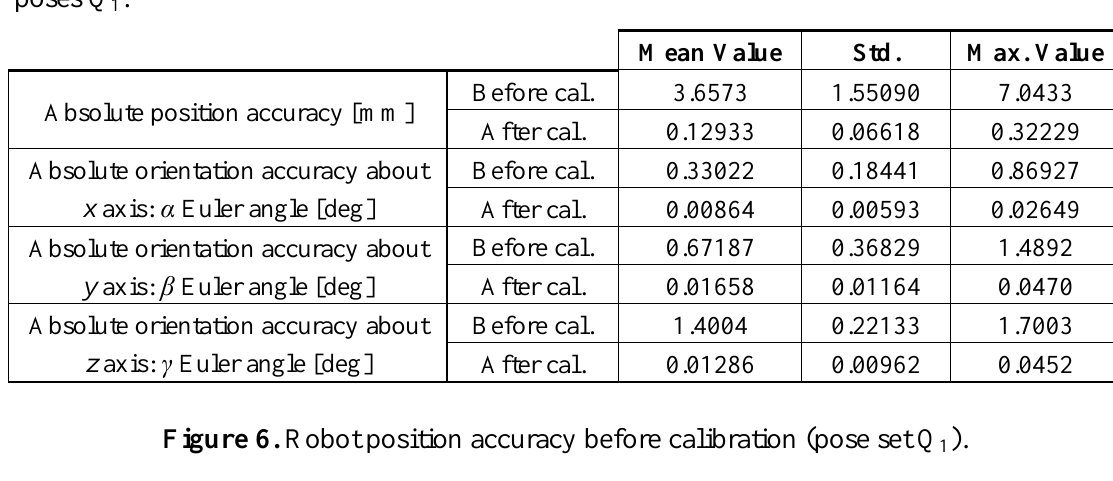
Table 4. Absolute position and orientation accuracy of the robot over the set of 56 robot poses Q . 1